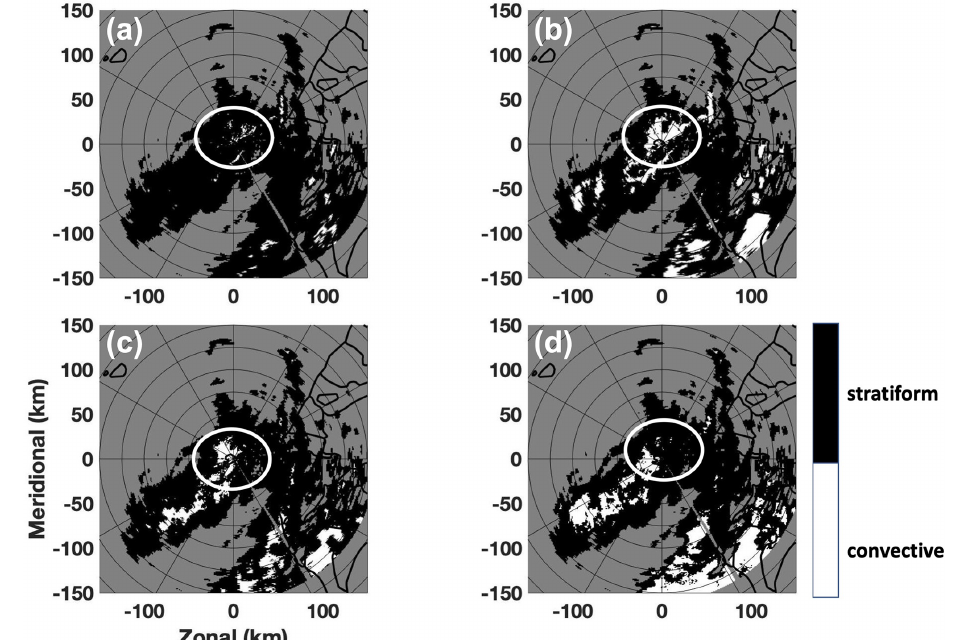
Figure 5. The classification results from BAL 0 (a ), BAL − 0 . 5 (b) , SVM (c) , and MRMS (d) . The time stamp for BAL 0 , BAL − 0 . 5 , and SVM is 03:03UTC, 30 August 2011, and time stamp for MRMS is 03:00UTC, 30 August 2011. The region inside the white circle is used in the analysis.